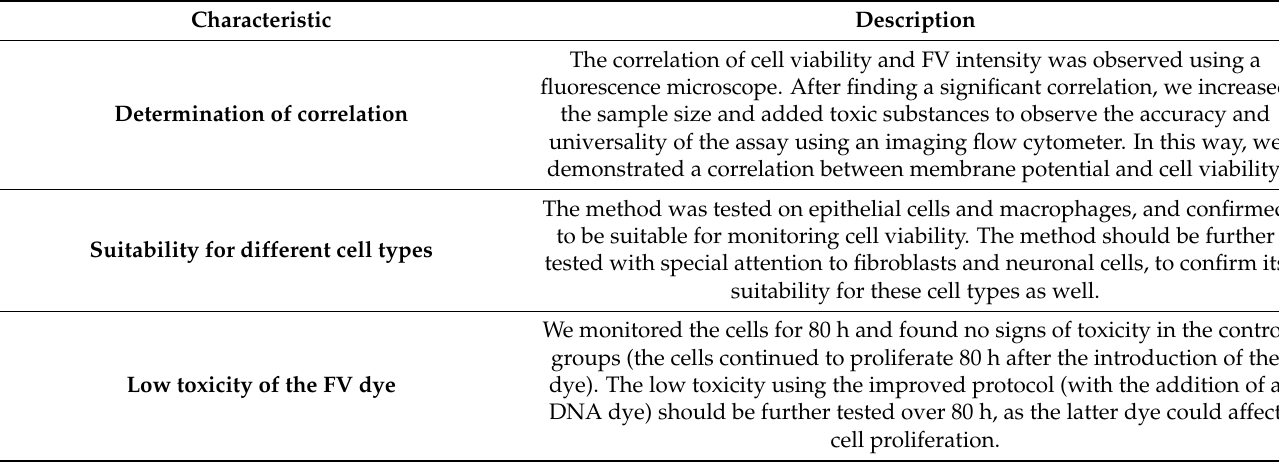
Table 1. Summary of the characteristics of the MPCVA